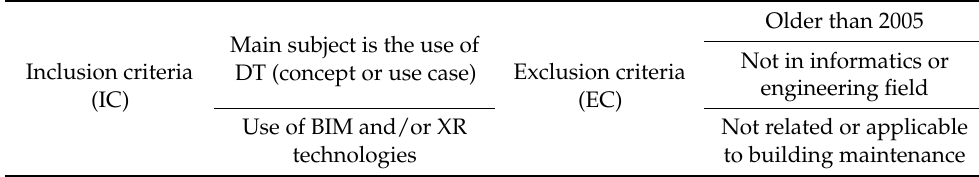
Table 1. Inclusion (IC) and exclusion (EC)